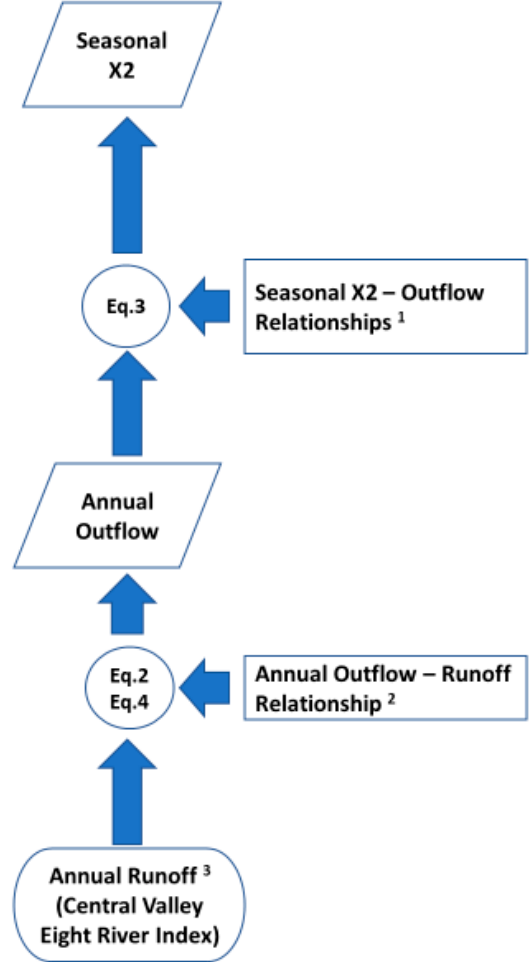
Figure 2. Flow chart for pre-development (Model 2) and contemporary (Model 3) models. 1 Model 2 calibration based on pre-development daily outflow (DWR, 2016) and daily X2-outflow relationship; Model 3 calibration based on historical daily and contemporary daily X2-outflow relationship; 2 Model 2 calibration based on pre-development annual outflow and historical Eight River Index (WYs 1922–2014); Model 3 calibration based on historical annual outflow and historical Eight River Index (WYs 1912–2018); 3 Tree-Ring reconstruction from Model 1 for long record and short record through WY